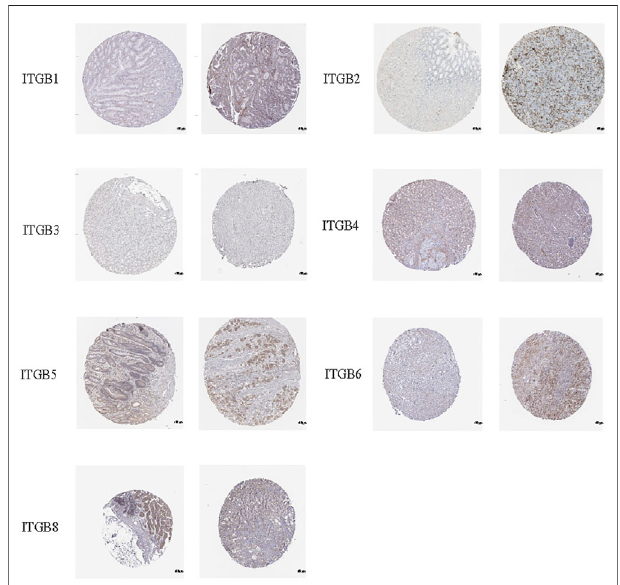
FIGURE 4 | IHC analysis of ITGBs in GC (the HPA database).